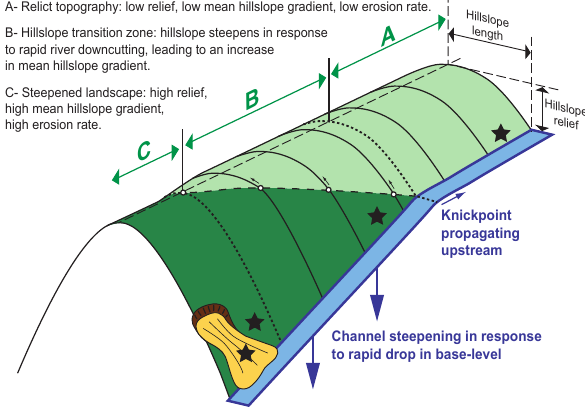
Figure 2. Schematic illustrating the typical morphology of the Feather River’s tributary basins (adapted from Hurst et al., 2012). In response to a rapid drop in base level, a knickpoint propagates up- stream along the channel, separating the steepened landscape from the relict topography. A break in slope also propagates up the hill- slopes (dots with arrows) in response to the increase in channel downcutting rate. Stars schematically represent the location of sam- pling sites with respect to morphological domains: on the relict to- pography (domain A, site identifier POMD), in the transition zone where the hillslopes have not completely adjusted (domain B, site identifier FTA) and in the steepened area below the break in slope (domain C, site identifier BRC and BRB for soils and LD for land- slides). Note that the width of domain B is a function of the response time of the hillslopes (the shorter the response time, the narrower the domain B). The mean hillslope gradient S h used in this study is the ratio of hillslope relief to hillslope length (shown on